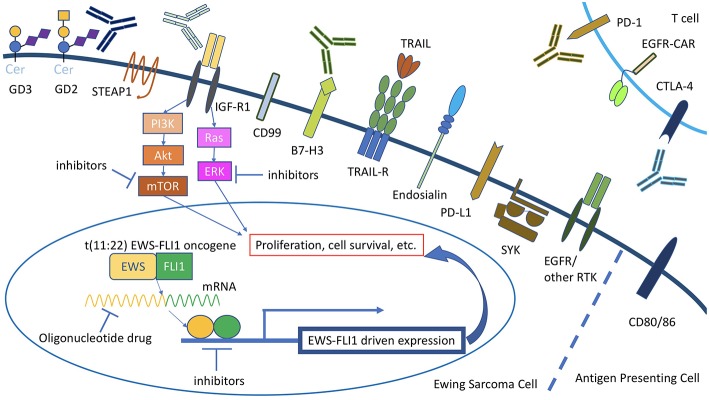
Overview of current molecularly targeted therapy for Ewing sarcoma. For STEAP1 and CD99, antibodies have been tested in mouse models of Ewing sarcoma but not in the clinical trial setting. Cer, ceramide.